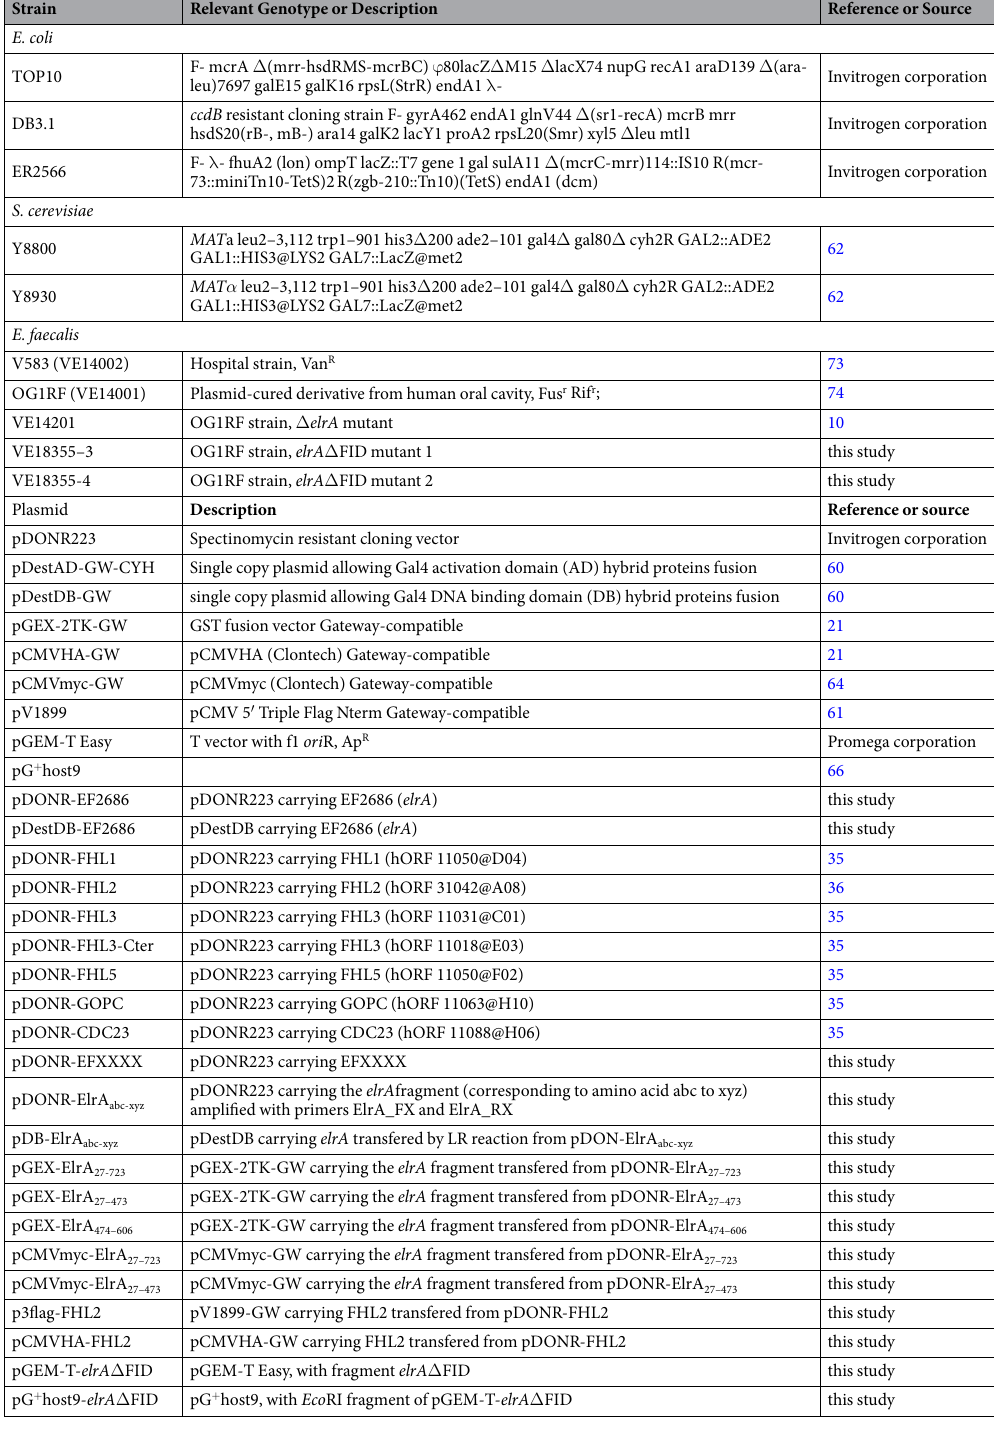
Table 2. Strains and plasmids used in the current